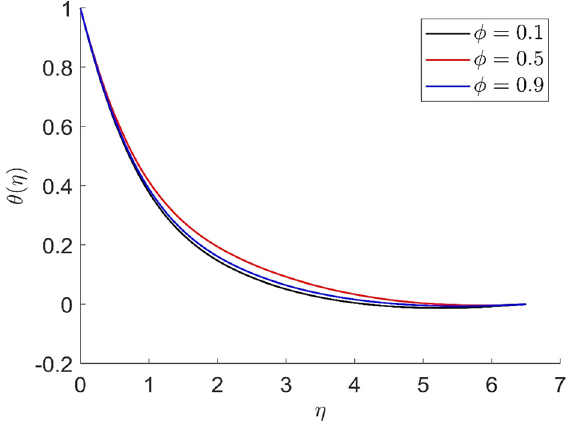
Figure 12. Representation of temperature θ(η) for the different values of φ with R = 3, n = 3, v = 0.8, m = 3.5, Pr = 0.7, φ 1 = 0.2, φ 2 = 0.4, β 3 = 0.6, β = 0.4, β 1 = 0.3, β 2 = 0.5, u = 0.4, ξ =